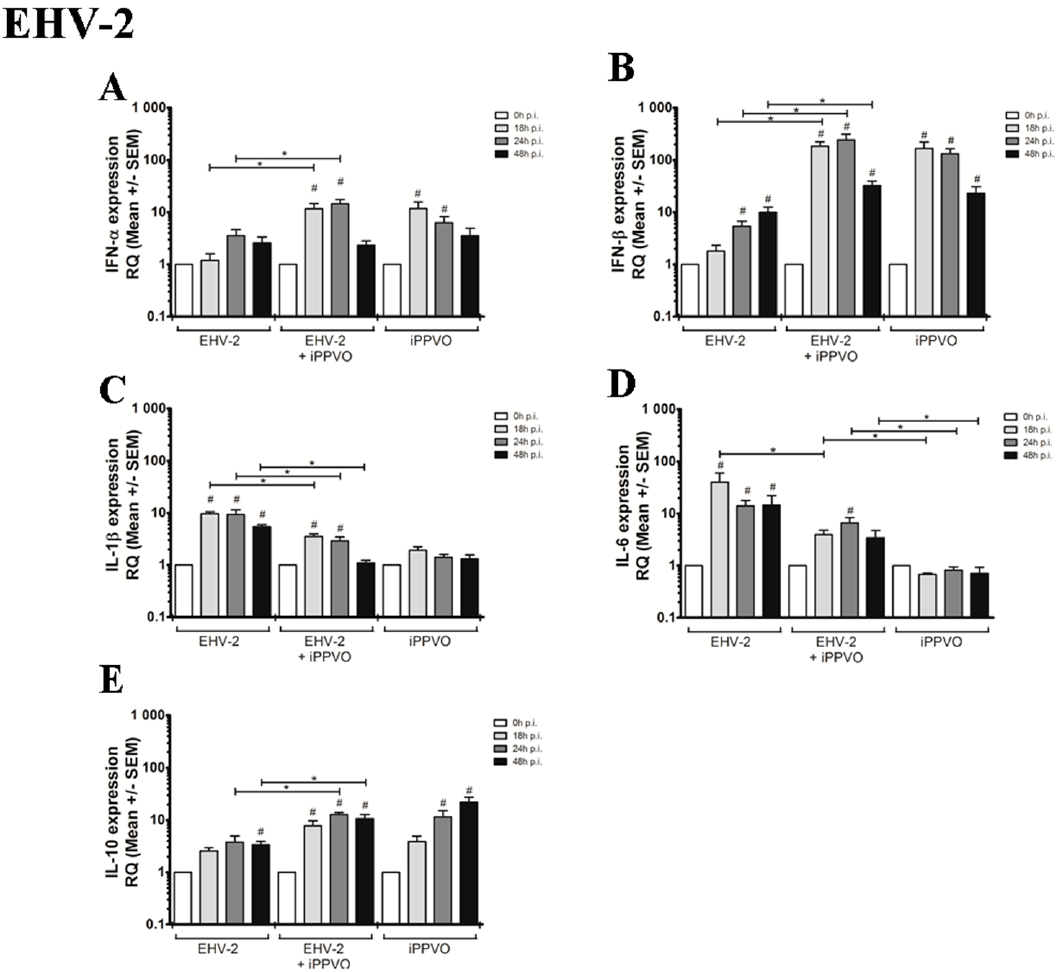
Figure 4. Cytokine mRNA expression measured by real-time PCR after infection of PBMC with EHV-2 alone, after co-treatment iPPVO/EHV-2, and after iPPVO treatment. Cytokines measured were IFN- α ( A ), IFN- β ( B ), IL-1 β ( C ), IL-6 ( D ), and IL-10 ( E ). White bars represent mRNA expression at 0 h (T 0 ), light grey bars represented mRNA expression at 18 hpi, dark grey bars at 24 hpi, and black bars at 48 hpi; n = 3 horses with 3 independent reverse-transcriptase PCR. Data are reported as means ± SEM as fold increase over the T 0 . The level of significance was set as p -value < 0.05. Significant differences compared to T 0 are indicated by # and differences between all conditions by star ( p < 0.05). The iPPVO/EHV co-infection condition was compared with EHV infection alone or iPPVO treatment alone.